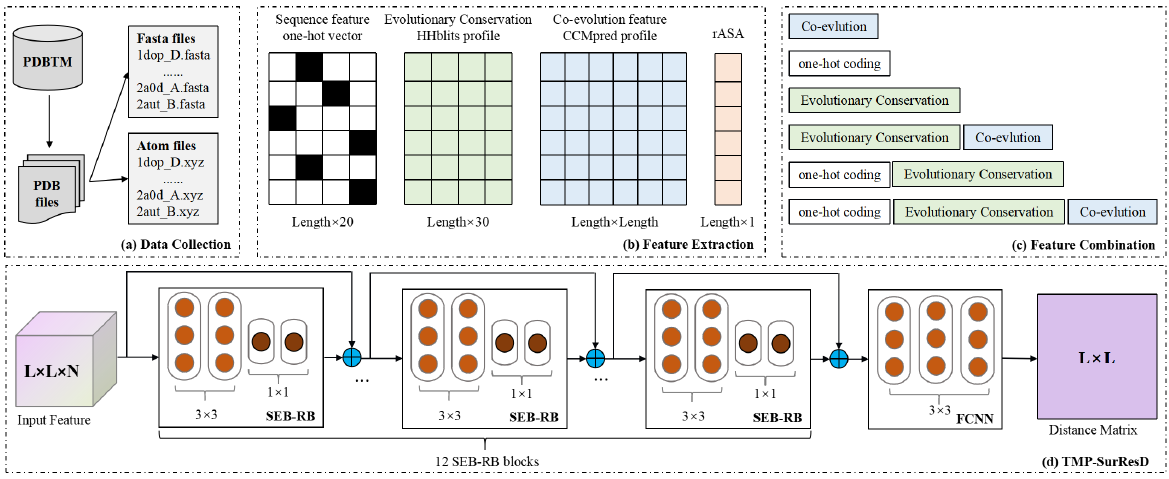
Figure 1. The workflow and architecture of